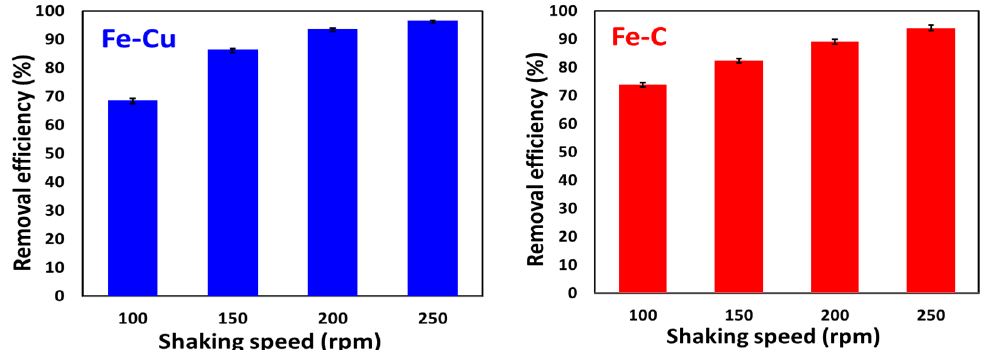
Figure 5. Effect of shaking speed on CIP removal under Fe-Cu and Fe-C